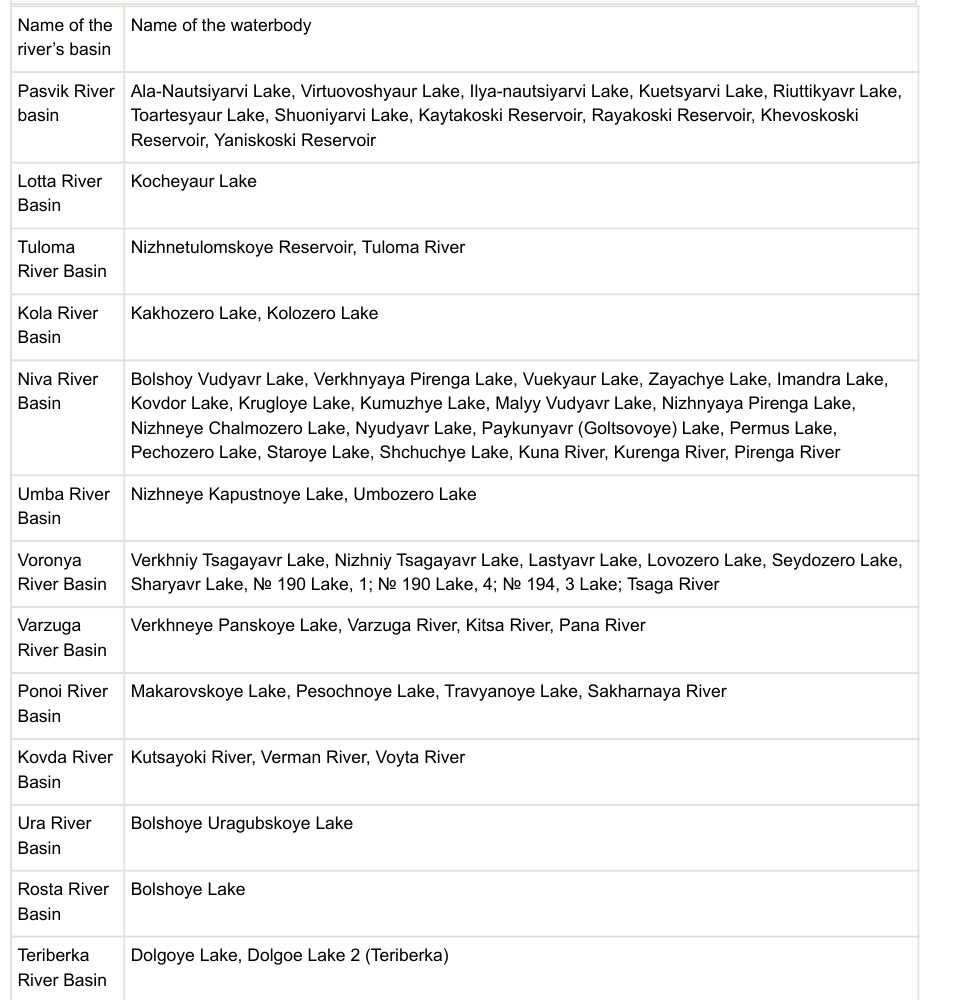
List of the freshwater waterbodies of the Murmansk Region and their basins with investigated fish fauna, Name of the Name of the waterbody river’s basin